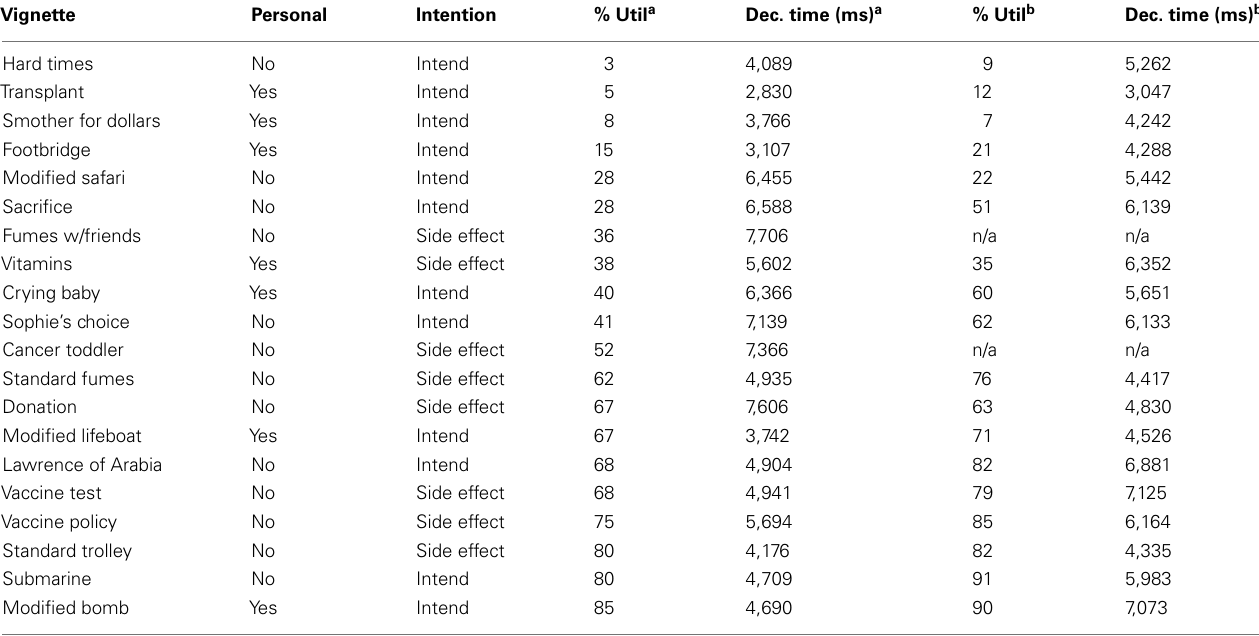
Table 1 |Vignettes used in Experiments 1 and 2 ranked by % utilitarian responses.